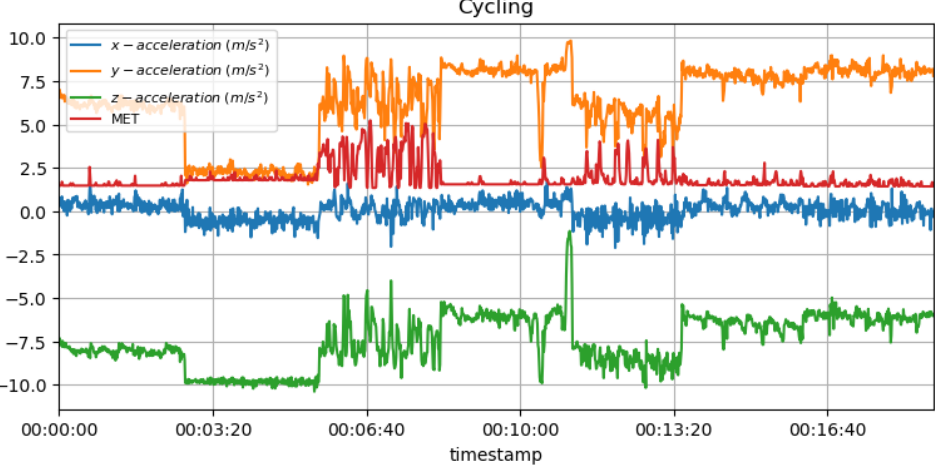
Figure 12. METs for cycling activity with acceleration